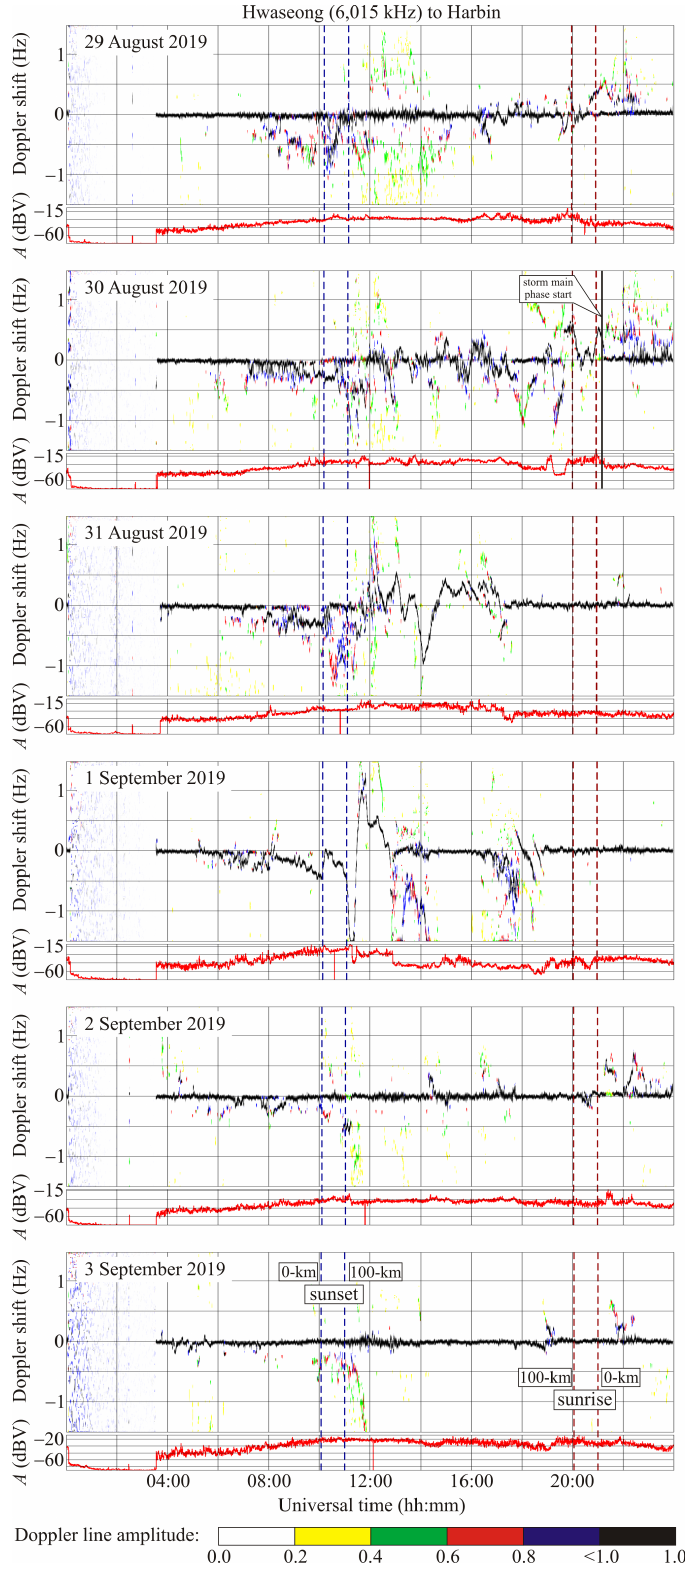
Figure 6. Same as Fig. 5 but for the Hwaseong to Harbin radio wave propagation path at